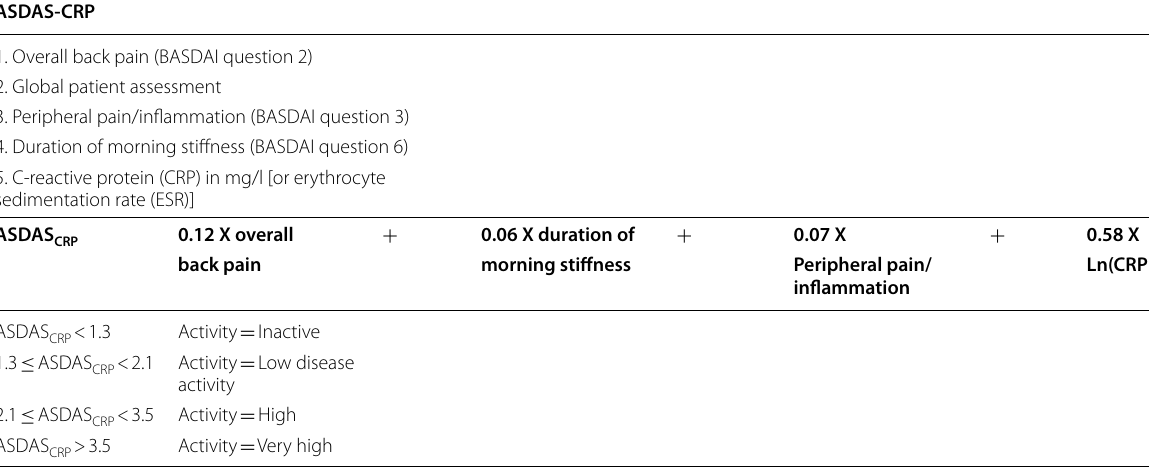
BASDAI: Bath Ankylosing Spondylitis Disease Activity Index mean of the values of questions 5 and 6 plus the values of questions 1 to 4, divided by 5 = Table 4 ASDAS‑CRP evaluation criteria for axial inflammatory activity in spondyloarthritis [8, 200, 201]